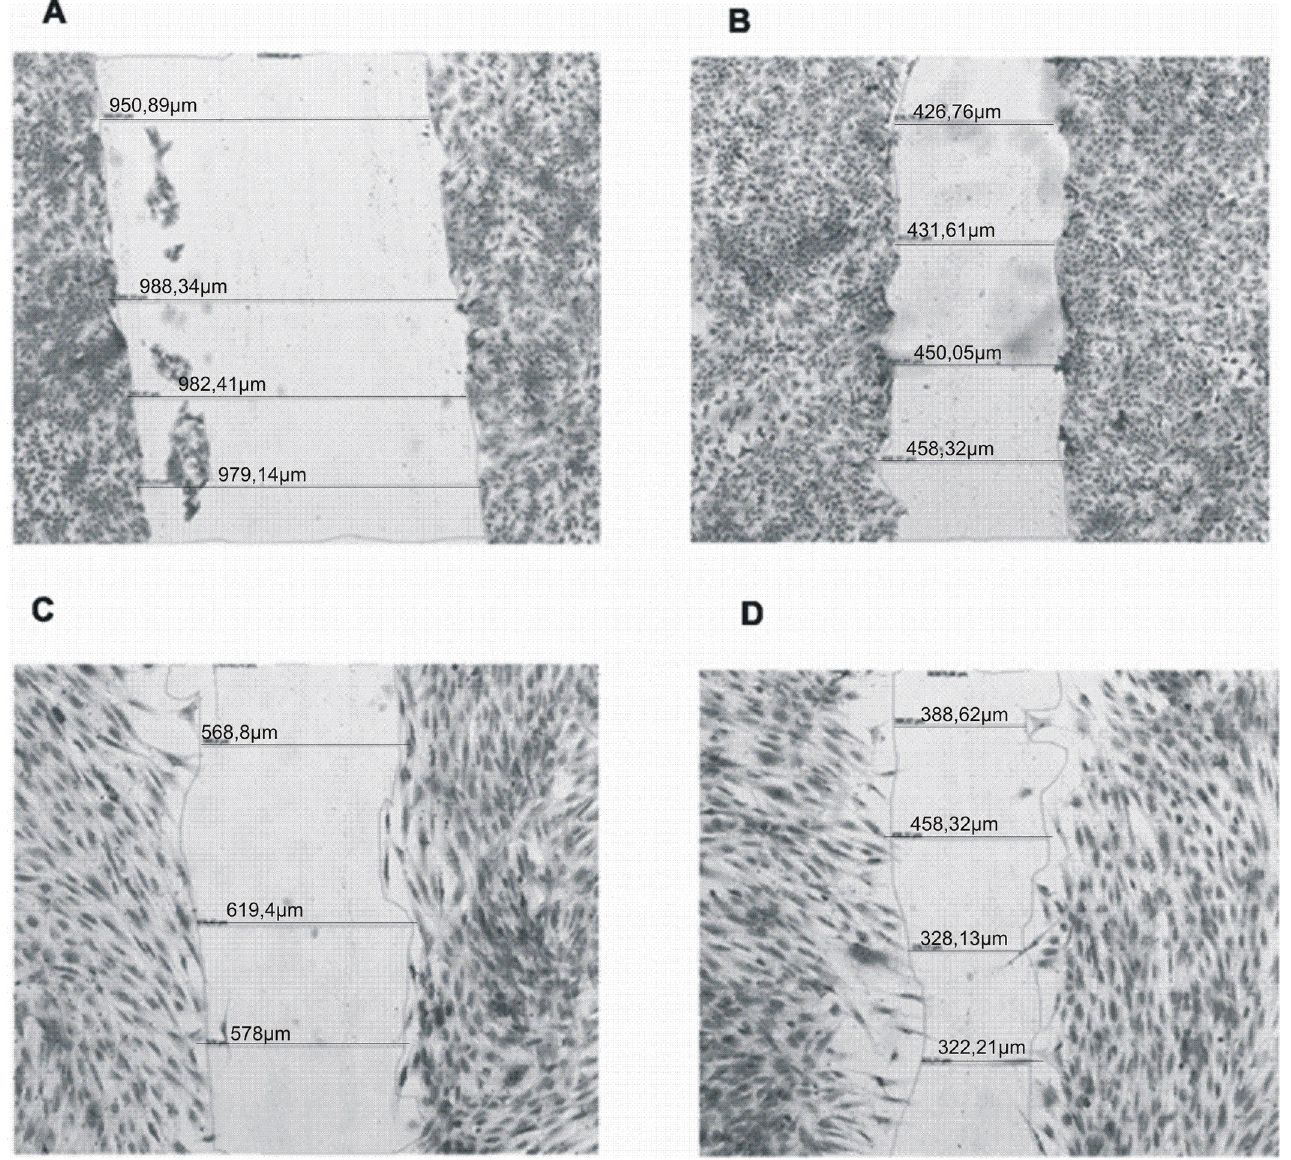
Fig 3. Stimulating effect of DAL-PEG-KSLW peptide on the migration of keratinocytes and fibroblasts after 24 hours of incubation. A — control probe for keratinocytes, B — migration of keratinocytes in the presence of the peptide (25 μ g/mL), C — the control probe for fibroblasts, D- migration of fibroblasts in the presence of the peptide (25 μ g/mL). HaCaT cells and fibroblasts were grown on the 6-well plates to confluence. Then cells were serum-starved for the next 12 hours. After that, the medium was changed and cells were stimulated with the tested peptides applied at concentration of 25 μ g/mL. Incubation was continued for the next 24 hours, then cells were fixed, dyed with 0.05% of crystal violet and analyzed using Zeiss Observer D1